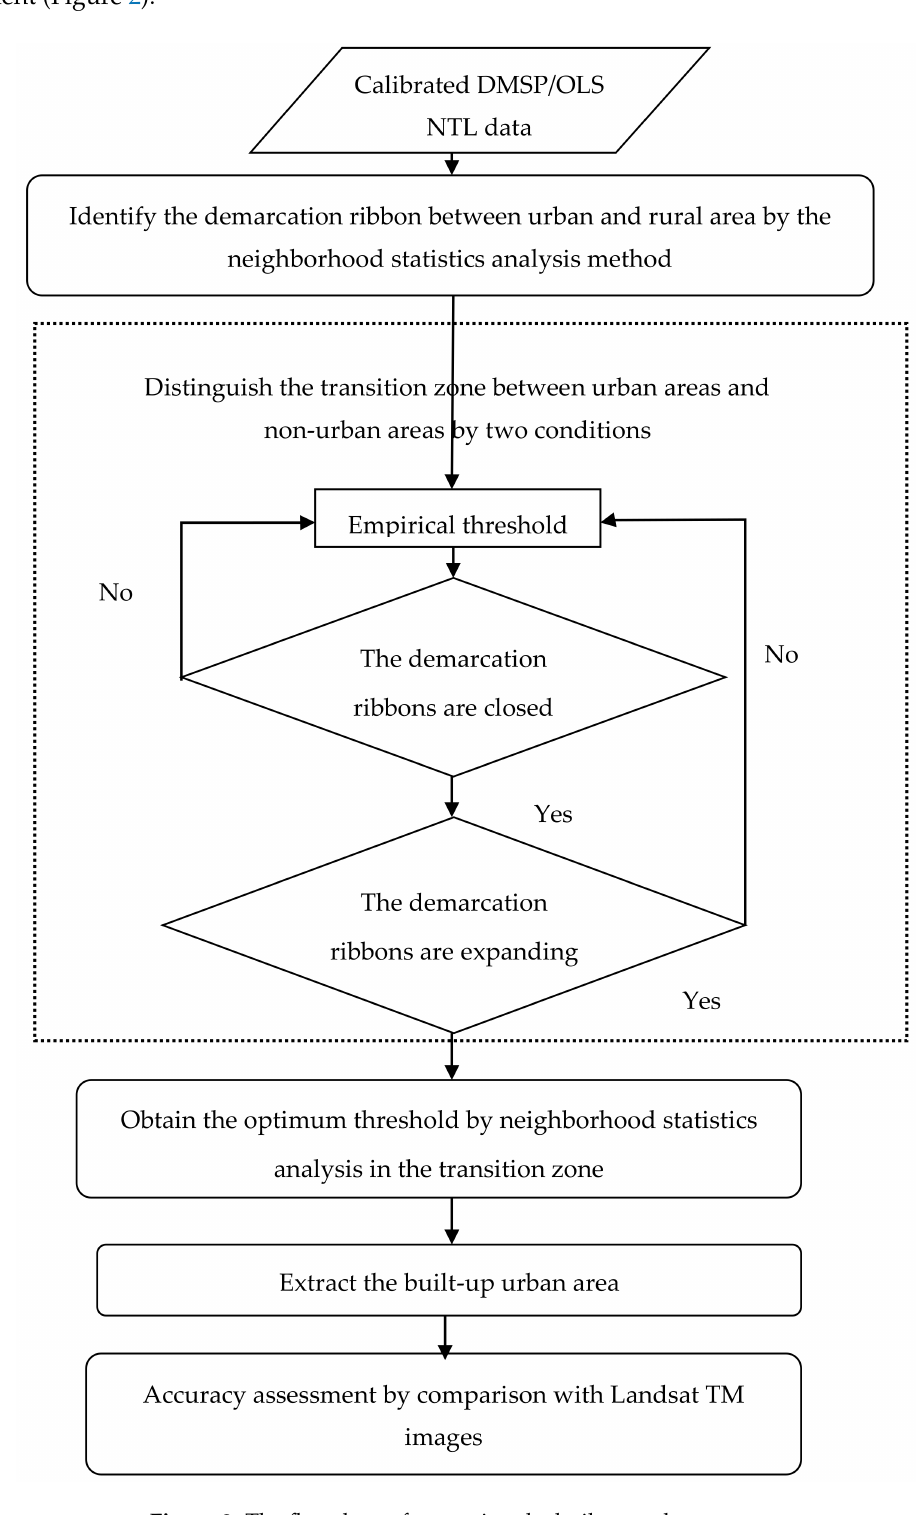
Figure 2. The flowchart of extracting the built-up urban